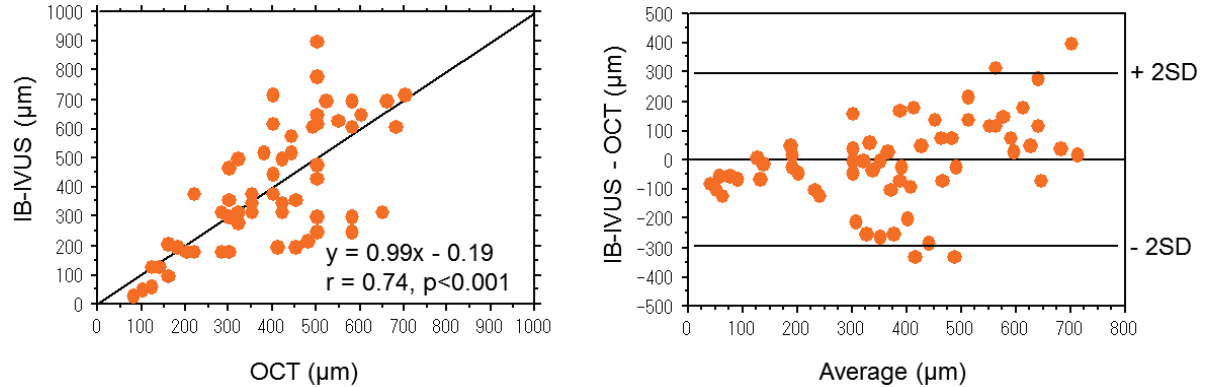
Figure 6. ( Left ) Correlation between the thickness of fibrous cap measured by integrated backscatter intravascular ultrasound and optical coherence tomography; ( Right ) Bland-Altman